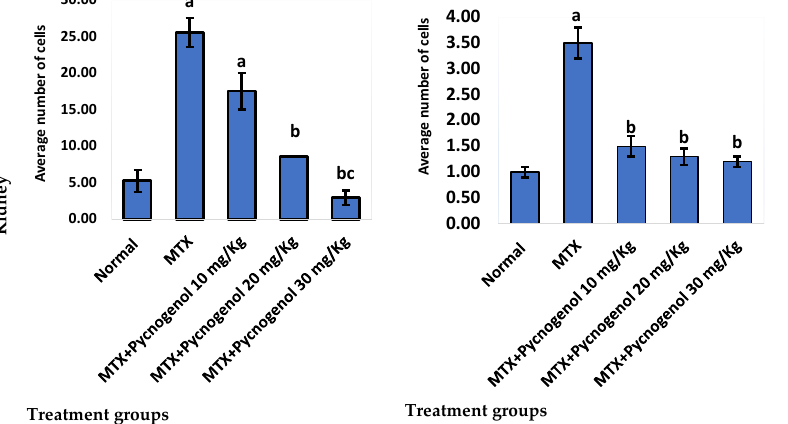
Figure 9. Immunohistochemical staining with IHC-caspase 3 and IHC-P53 of heart, liver, and kidney tissue. Differences assessed by Kruskal–Wallis test at p = 0.05. a Significantly different from normal group. b Significantly different from MTX group. c Significantly different from MTX + pycnogenol (10 mg/kg).